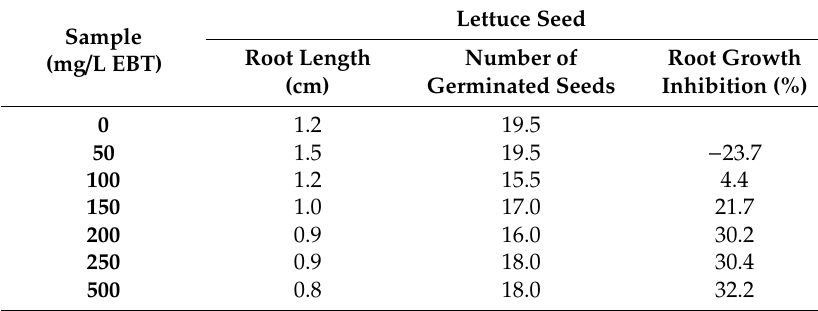
Table 2. Seedling growth inhibition